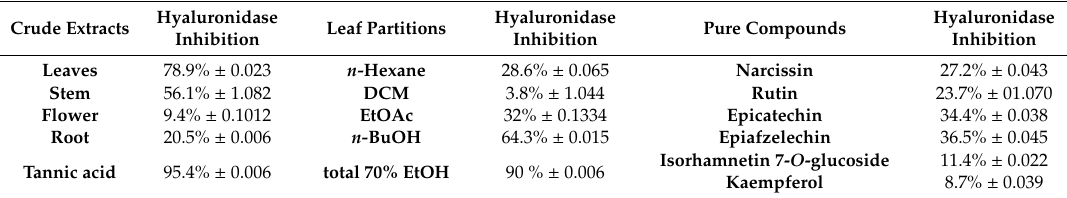
Table 1. Hyaluronidase inhibition of Ravenala madagascariensis ethanolic extracts and pure compounds isolated in this study.